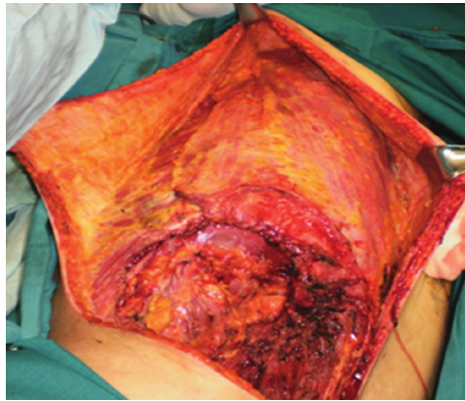
Figure 7: Dissection of the perforators.